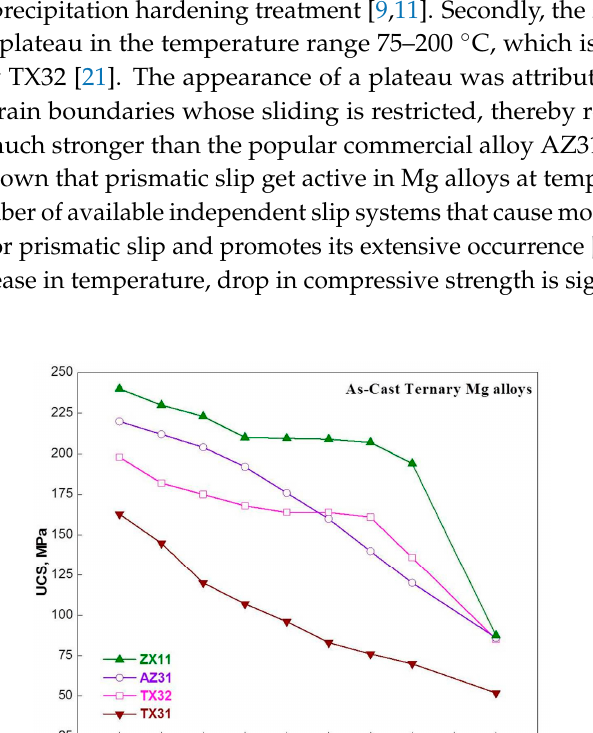
Figure 3. Ultimate compressive stress (UCS) of ZX11 alloy compared with common ternary Mg alloys [21,22].